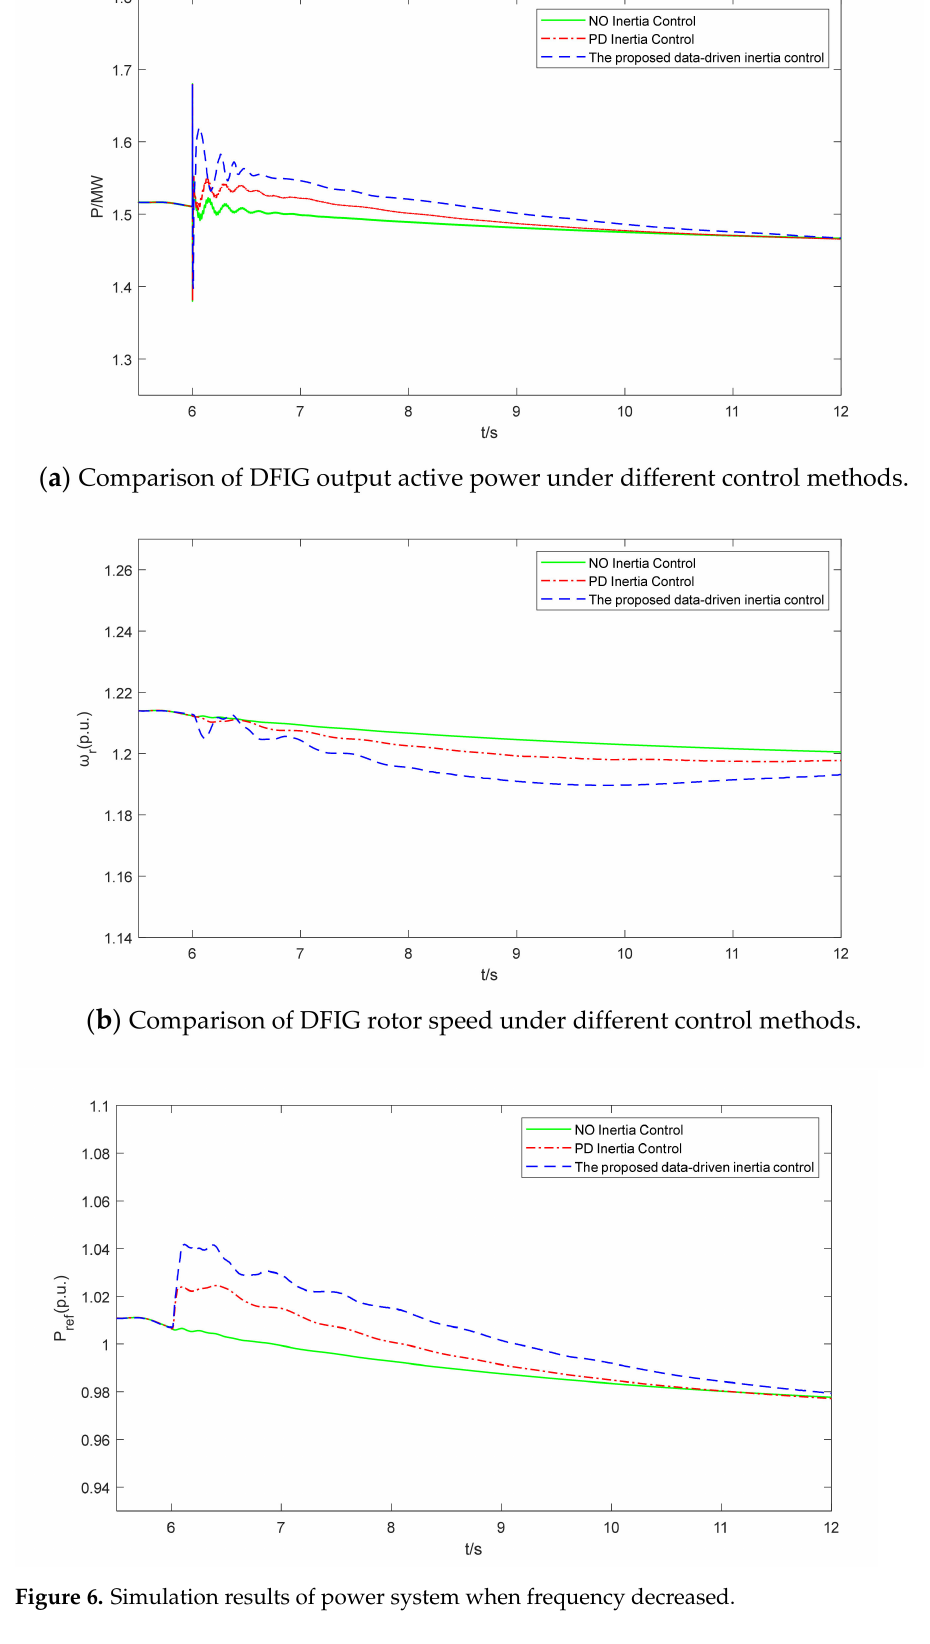
Figure 6. Simulation results of power system when frequency